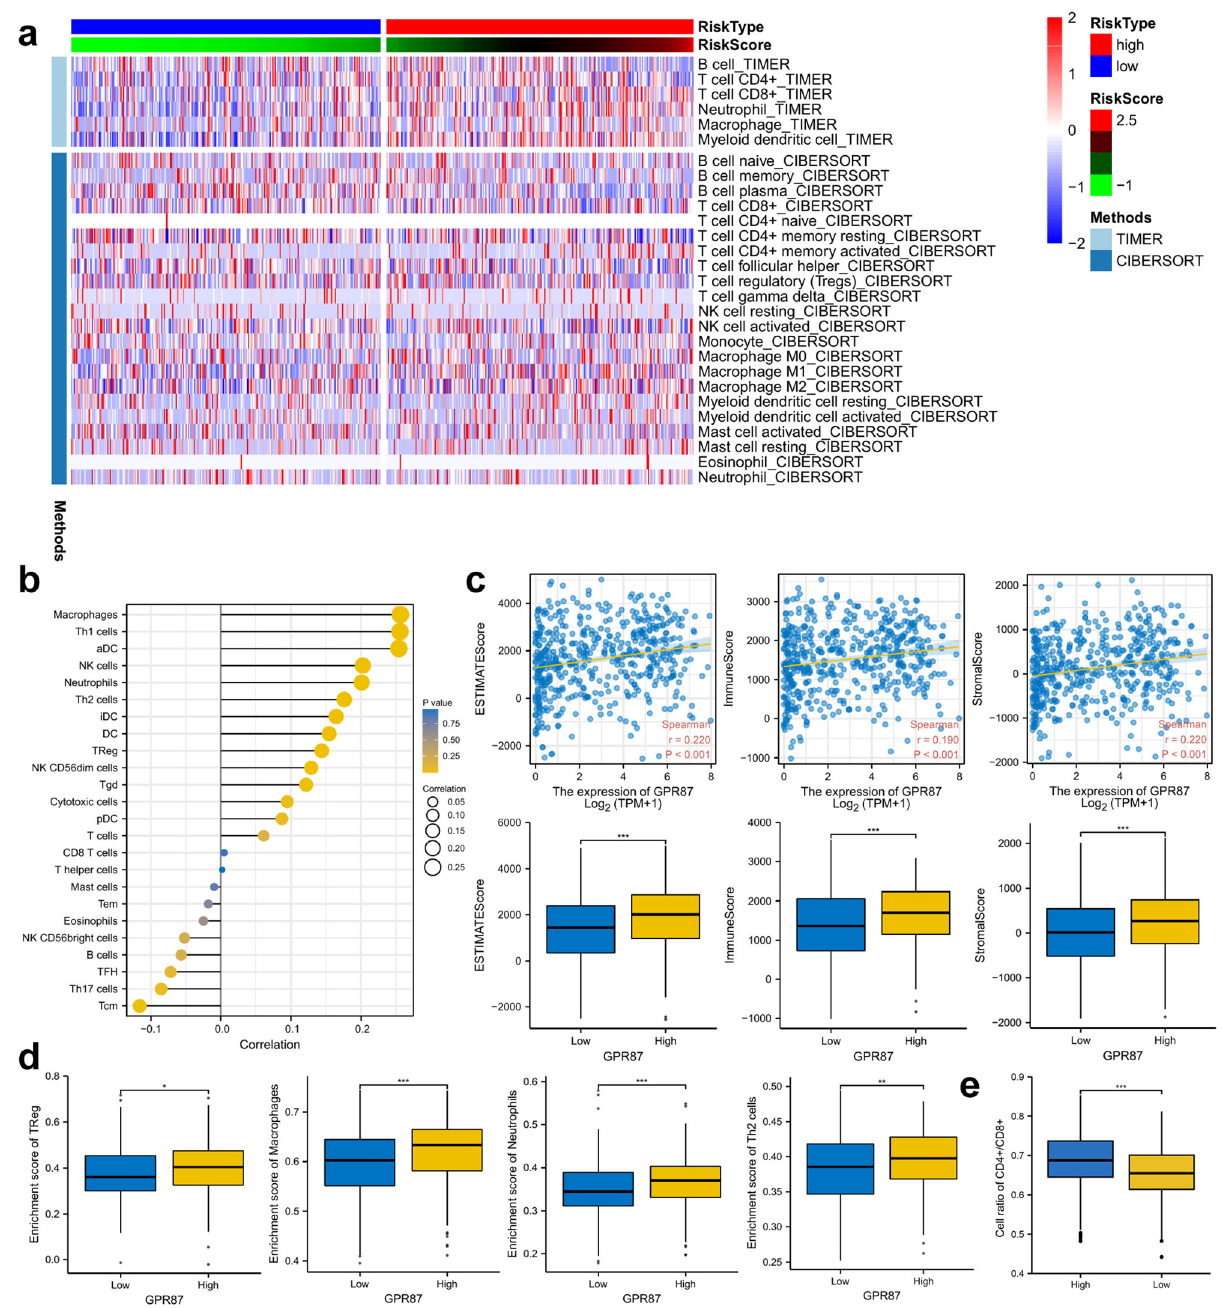
Fig. 6 The relationship between GPR87 expression and immune cell in fi ltration. a Heat map demonstrating the level of immune cell in fi ltration in patients with high and low GPR87 expression, with immune cell in fi ltration evaluated by TIMER and CIBERSORT algorithms. b Lollipop graph shows the correlation between GPR87 expression and immune cells. c GPR87 was analyzed in correlation with immune scores and stromal scores, and differences in immune scores and stromal scores were analyzed in patients with high and low expression of GPR87 . The immune scores and stromal scores were calculated by the ESTIMATE algorithm. d Differential analysis of regulatory T cells, macrophages, neutrophils, and T helper 2 cells in patients with high and low expression of GPR87 . e Analysis of differences in CD4 + /CD8 + cell ratios between patients with high and low expression of GPR87